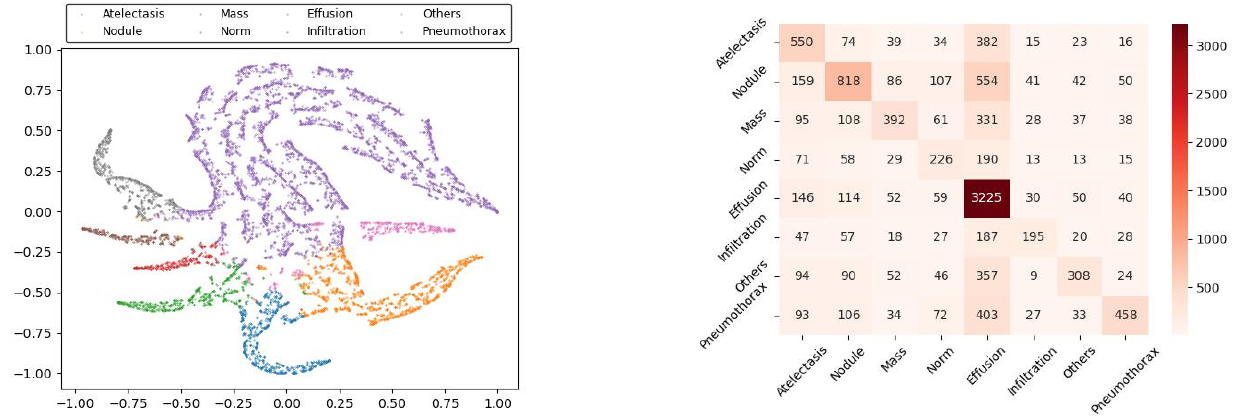
Figure 3. The visual representation of K-means clustering results: feature distribution after clustering ( left ); distances between the predicted label and the real label ( right ).